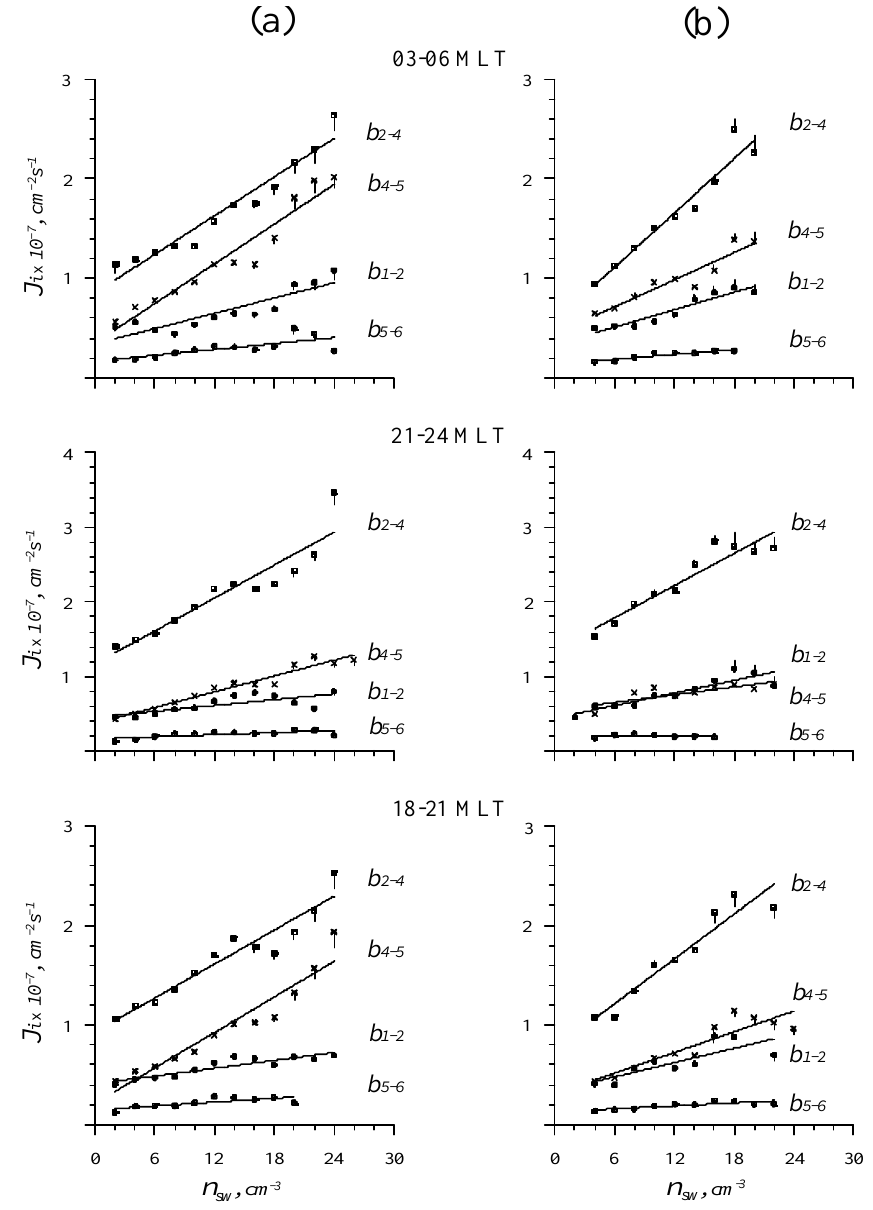
Fig. 1. Ion number flux in four precipitation regions ( b 1– b 2 i , b 2 i – b 4 s , b 4 s – b 5 and b 5– b 6) versus solar wind plasma density in the morning, pre-midnight and evening MLT sectors during periods of northward (a) and southward (b) IMF